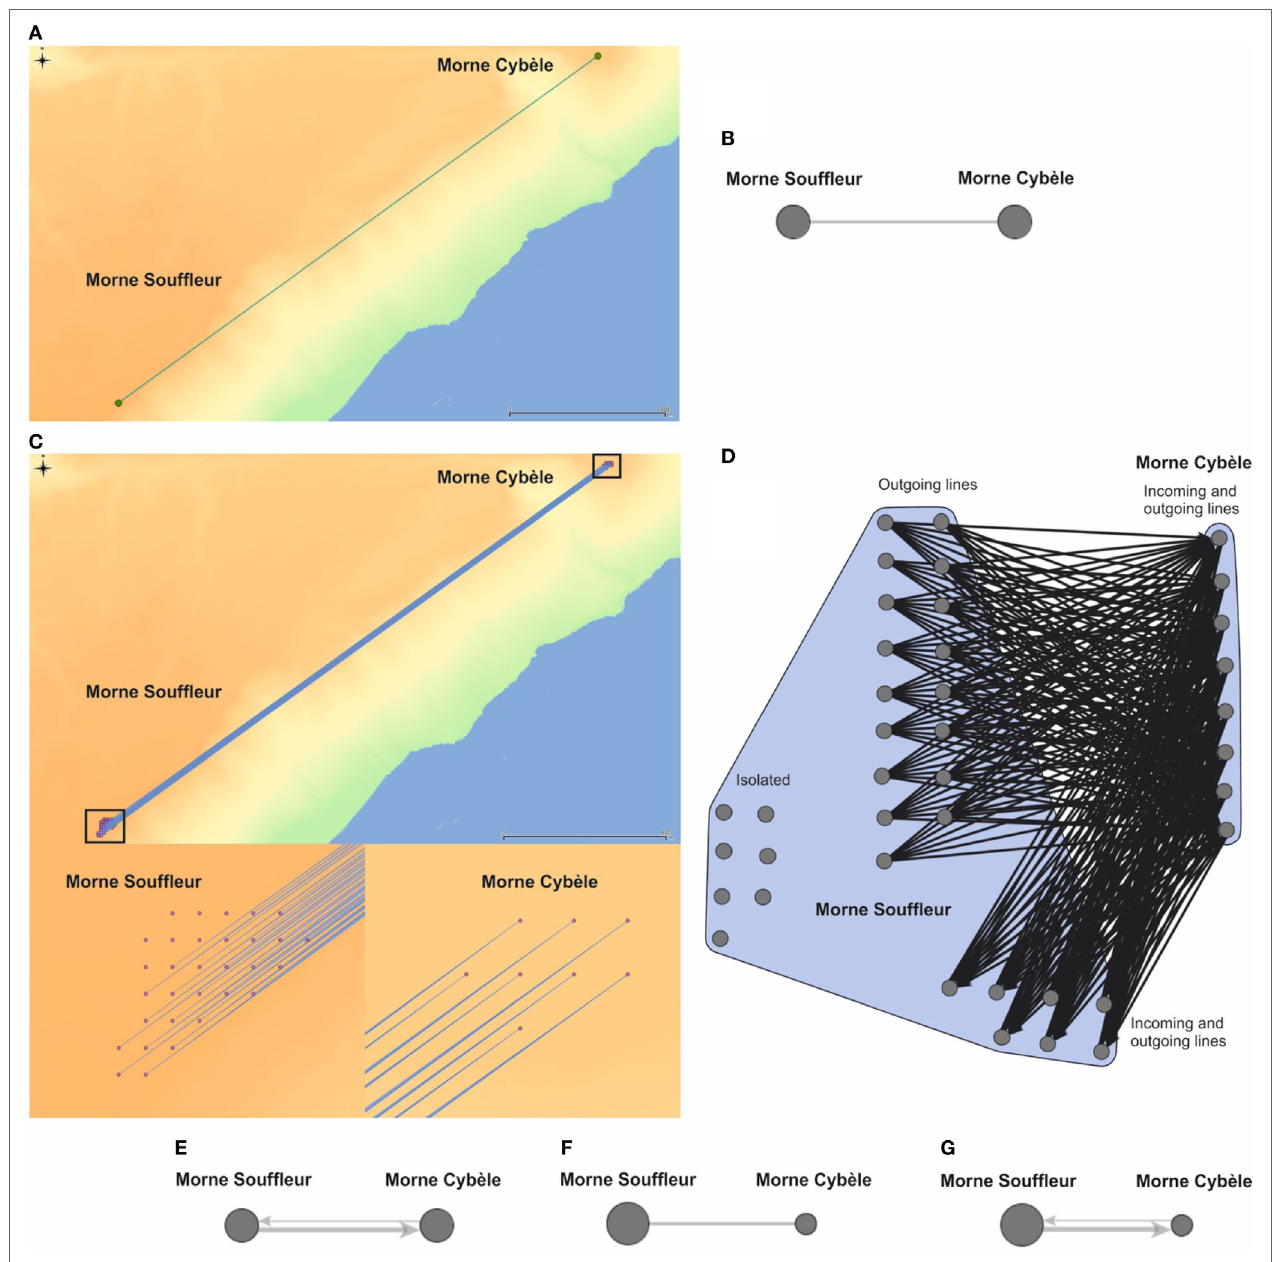
FigUre 1 | Alternative representations of a visibility network between a pair of sites: single node per site (a,B) ; nodes for each location within site area (c,D) ; directional arcs representing bundled lines-of-sight (e) ; site area represented as node attribute (F) ; combination of (e,F) (g)